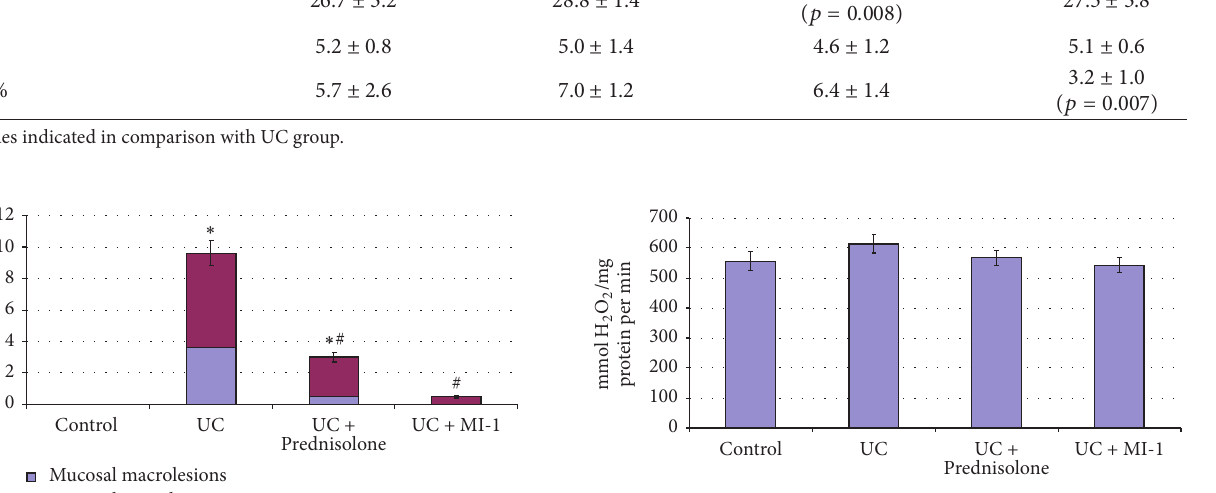
Figure 6: Bowel mucosa CAT activity for rats experiencing UC and treated with Prednisolone and MI-1.